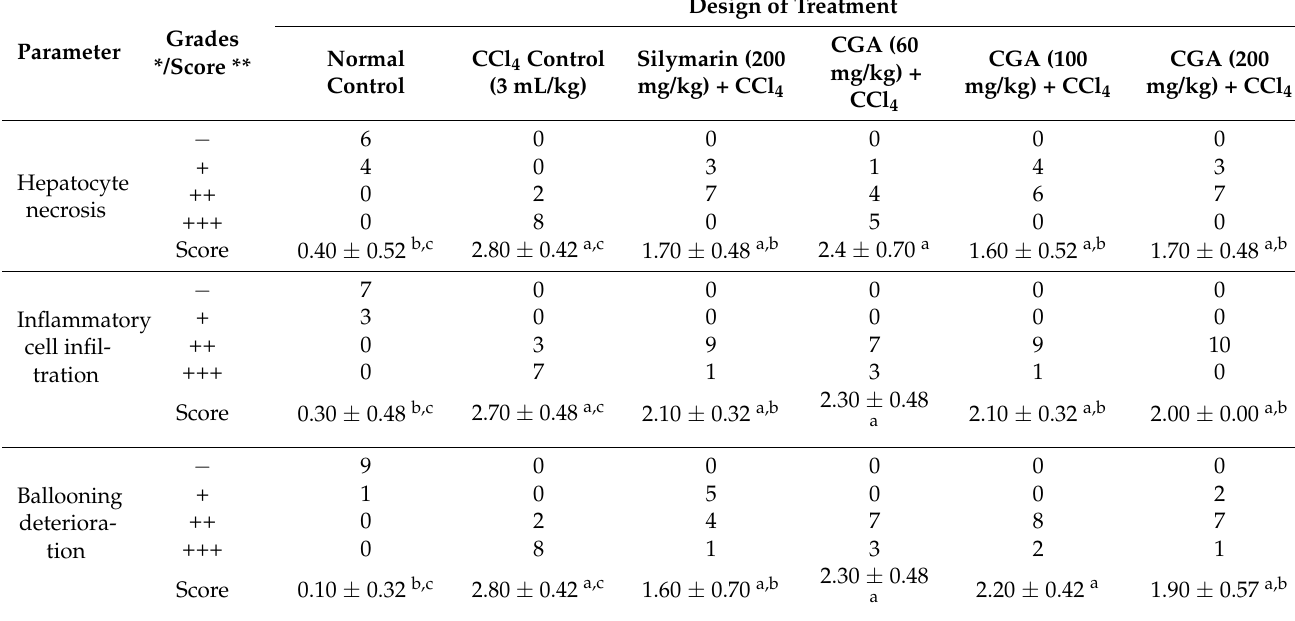
Table 4. Effects of CGA on hepatic histopathology of liver injury in mice treated with CCl 4